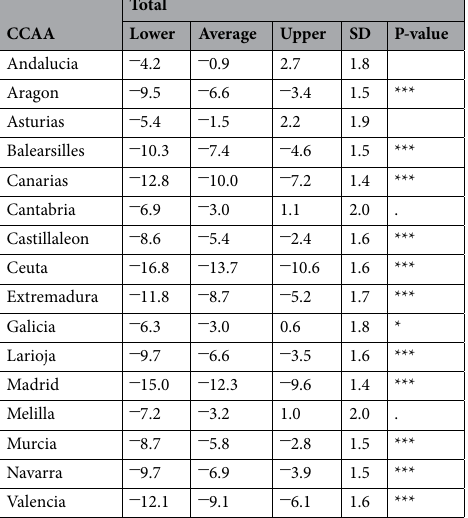
Table 9. Bayesian structural time series estimates. Note: All values in %. 1 *** 0.1%, ** 1%, * 5%, . 10% significance